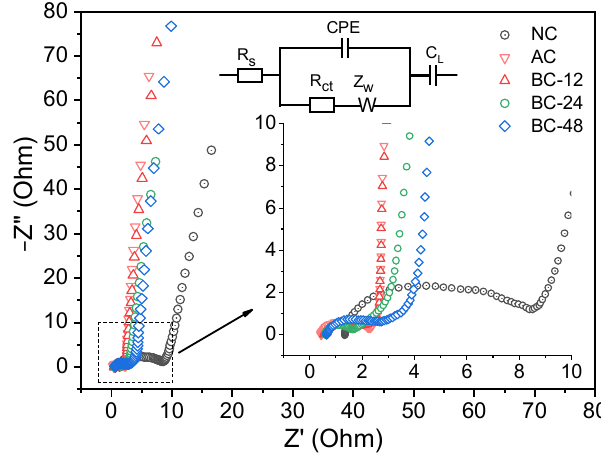
Figure 4. Nyquist plots of the indicated biochar electrodes.